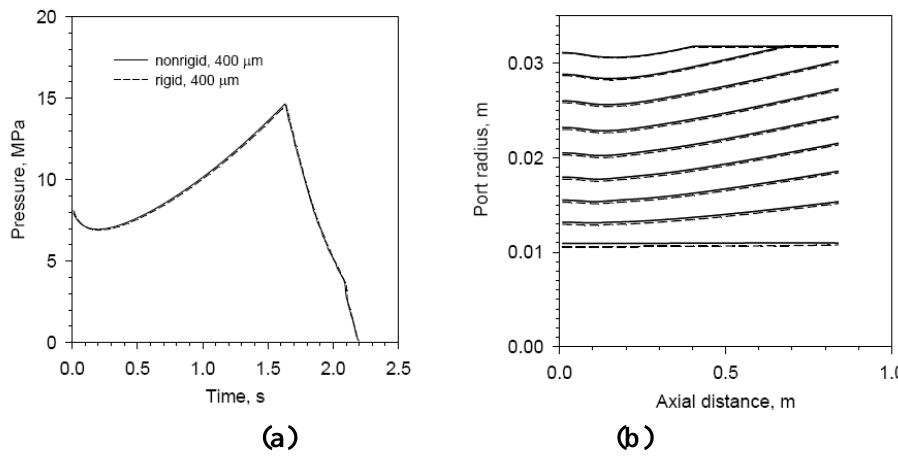
Figure 6. (a) Predicted head-end pressure profile for small cylindrical-grain SRM, rigid and nonrigid cases; (b) Predicted port grain radius profile, with (solid curves) and without pressure loading (dashed curves), at 0.25-sec